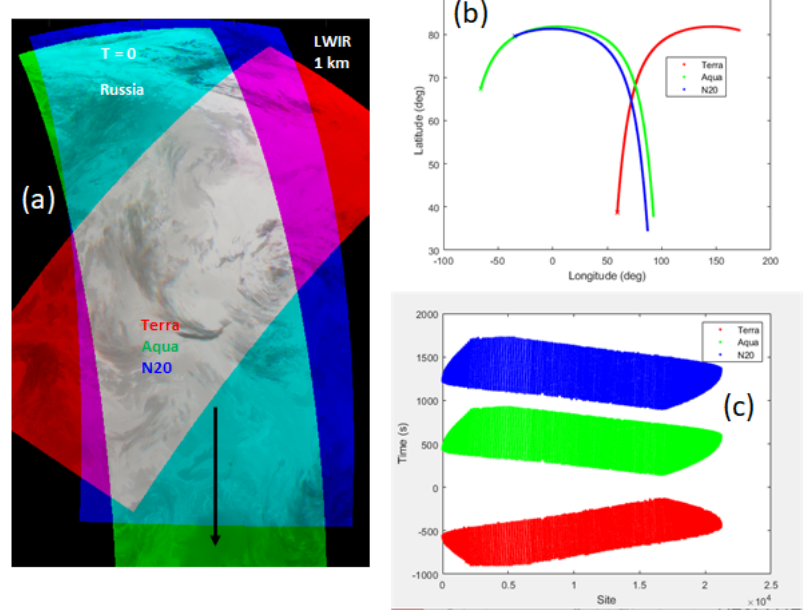
Figure 3. A crossing configuration is formed with MODIS on Aqua and Terra and VIIRS on N20. Panel ( a ) shows the overlapping Long-Wave IR (LWIR) imagery compositing MODIS band 31 with VIIRS band M15. Granule times are 1 October 202 with Terra starting 6:45Z, Aqua starting 7:00Z, and N20 starting 7:12Z. Panel ( b ) shows the satellite ground tracks and panel ( c ) shows the pixel times relative to 1 October 2020 7:00Z plo tt ed by site number covering the full triple overlap.